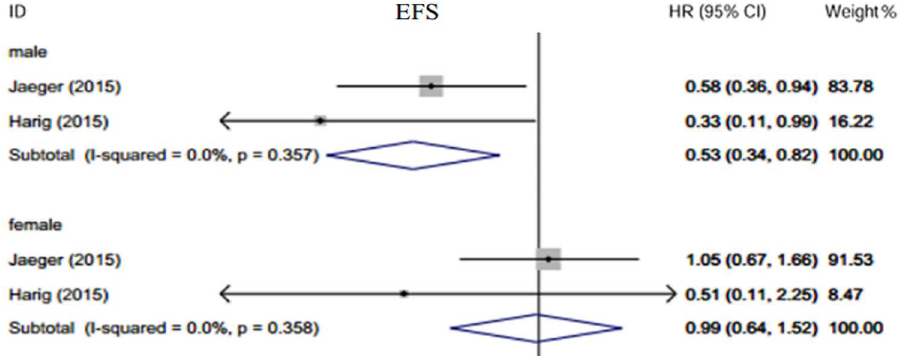
Fig 5. Subgroup analysis according to sex. Male patients benefit more in EFS than female from rituximab maintenance